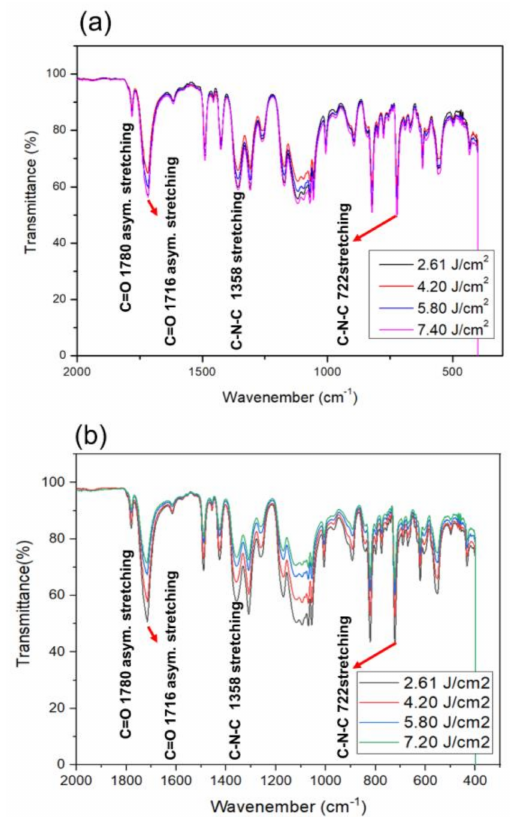
Figure 9. Measurement of FTIR to observe the change of film surface according to XFL energy: ( a ) top side and ( b ) bottom